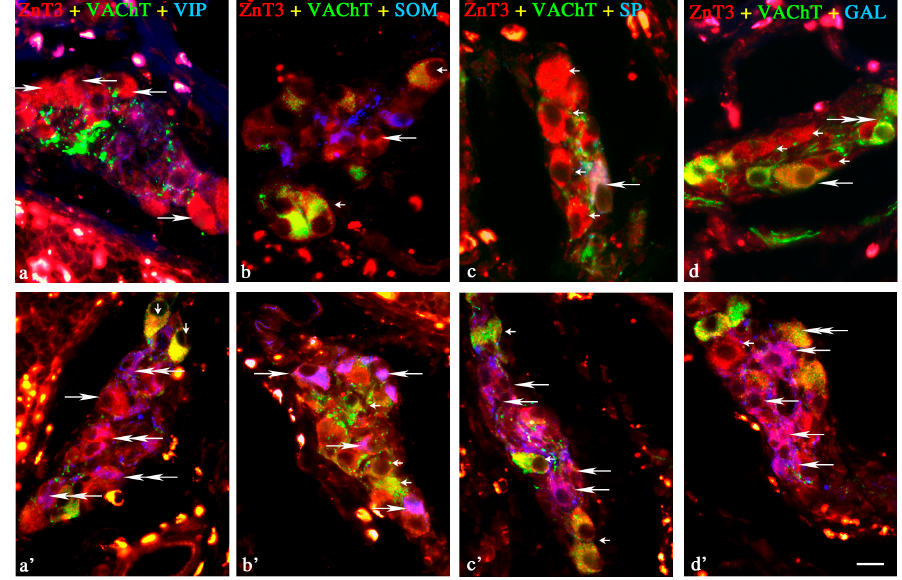
Figure 3. Representative images of ZnT3+ neurons located in the inner submucous plexus (ISP) of porcine ileum. All images are composites of merged images taken separately from blue, red and green fluorescent channels. Control (C) group: ( a ) ZnT3 + /VAChT − /VIP − neurons are indicated with arrows; I group ( b ) ZnT3 + /VAChT + /SOM − neurons are indicated with small arrows; ZnT3 + /VAChT − /SOM − neuron is indicated with an arrow; ( c ) ZnT3 + /VAChT − /SP − neurons are indicated with small arrows; ZnT3 + /VAChT + /SP + neuron is indicated with an arrow; ( d ) ZnT3 + /VAChT − /GAL − neurons are indicated with small arrows; ZnT3 + /VAChT + /GAL − neuron is indicated with an arrow; ZnT3 − /VAChT + /GAL − neuron is indicated with a double-headed arrow; Inflammatory (I) group: ( a’ ) ZnT3 + /VAChT + /VIP − neurons are indicated with small arrows; ZnT3 + /VAChT − /VIP + neurons are indicated with double-headed arrows; ZnT3 + /VAChT − /VIP − neuron is indicated with an arrow; ( b’ ) ZnT3 + /VAChT − /SOM + neurons are indicated with arrows; ZnT3 + /VAChT + /SOM − neurons are indicated with small arrows; ( c’ ) ZnT3 + /VAChT − /SP + neurons are indicated with arrows; ZnT3 + /VAChT + /SP − neurons are indicated with small arrows; ( d’ ) ZnT3 + /VAChT + /GAL − neuron is indicated with a double-headed arrow; ZnT3 + /VAChT − /GAL − neuron is indicated with a small arrow; ZnT3 + /VAChT − /GAL + neurons are indicated with arrows. Scale bar 25 µm .